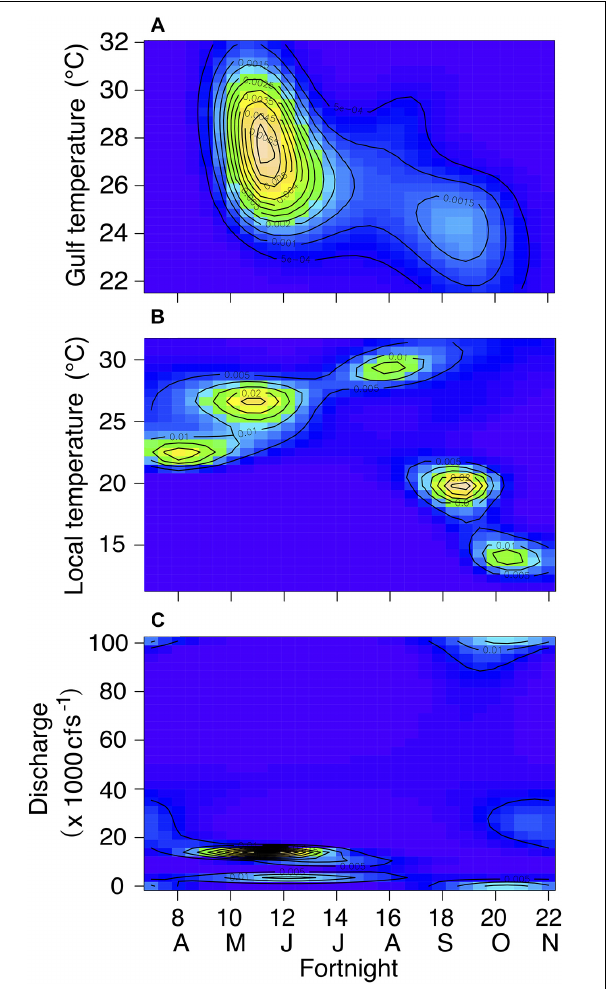
FIGURE 8 | Contour plots displaying interactions between fortnight period and nGoM water temperature (A) , local air temperature (B) , and freshwater discharge (C) for tagged individuals in fairways. Cooler colors (e.g., blue, green) indicate lower probabilities while warmer colors (yellow, tan) indicate higher probabilities. Contour lines represent